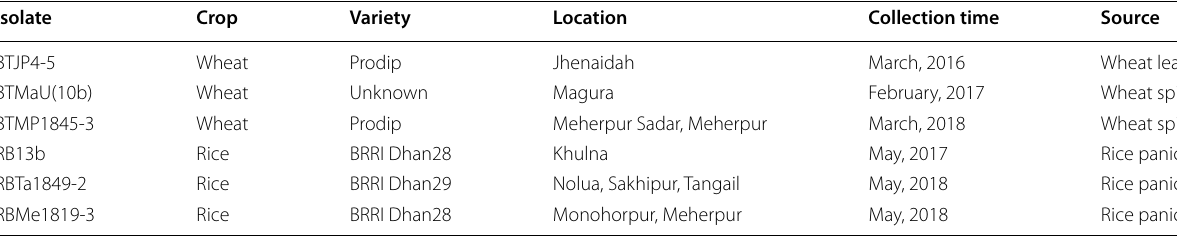
Table 3 List of Magnaporthe oryzae isolates used in this study Isolate Crop Variety Location BTJP4‑5 Wheat Prodip Wheat Wheat Prodip RB13b Rice BRRI Dhan28 RBTa1849‑2 Rice BRRI Dhan29 RBMe1819‑3